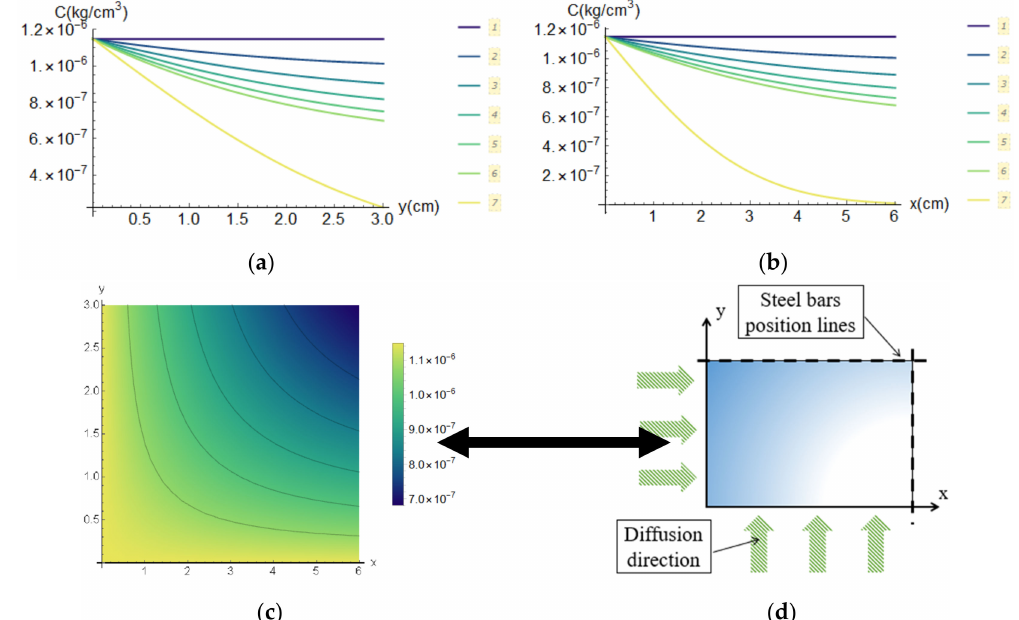
Figure 9. Numerical solution of the C(x,y,t) for f D (x,y,t) constant: ( a ) results in y domain; ( b ) results in x domain; ( c ) 3D complete results; ( d ) example of an RC beam (t m = 2 π years, 0 ≤ y ≤ 3 cm with